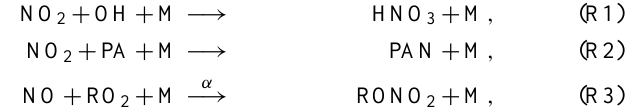
Figure 3. Diel averages of reactive nitrogen. Top: total NO y was a factor of 2.5 times larger in 2013 than in 2012. Middle: the amount of photochemically active NO x remained at similar levels all three years. Bottom: the ratio of NO x / NO y , an inverse measure of the level of oxidation of reactive nitrogen, was a factor of 2.6 smaller in 2013 than